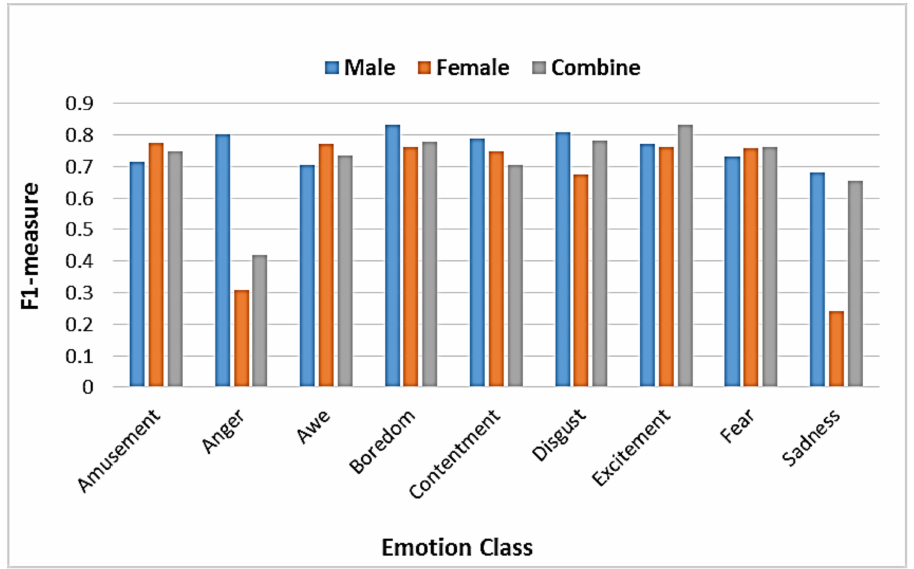
Figure 7. Best-case average F1-score for inferring emotion tags at bottom-level with nine di ff erent emotions using